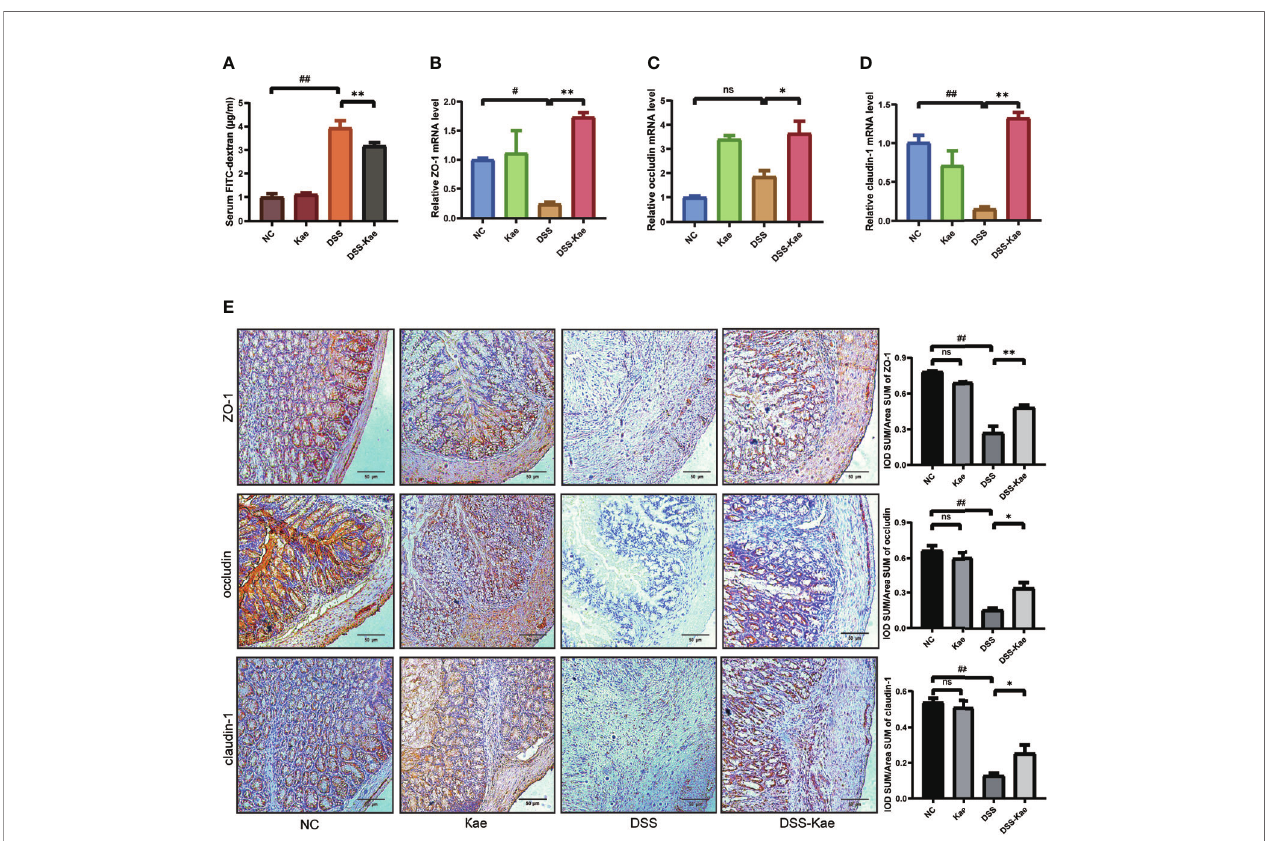
FIGURE 3 | Kae improves gut permeability and enhances expression of intestinal tight junction proteins. Relative mRNA levels analysis of (A) Quanti fi cation of serum FITC-dextran. (B) ZO-1 , (C) occludin , and (D) claudin-1 . (E) Representative images of immunohistochemical staining of ZO-1, occludin, and claudin-1 in colon samples from different experimental groups (scale bar, 50 m m). Positive protein integral optical density was determined using Image J 1.5.7 software. Data are expressed as the mean ± SEM, n = 5 – 6, analyzed using one-way ANOVA with Tukey post-hoc analysis. DSS ( vs . NC, # P < 0.05, ## P < 0.01; vs . DSS-Kae, * P < 0.05, ** P < 0.01); ns, no signi fi cant